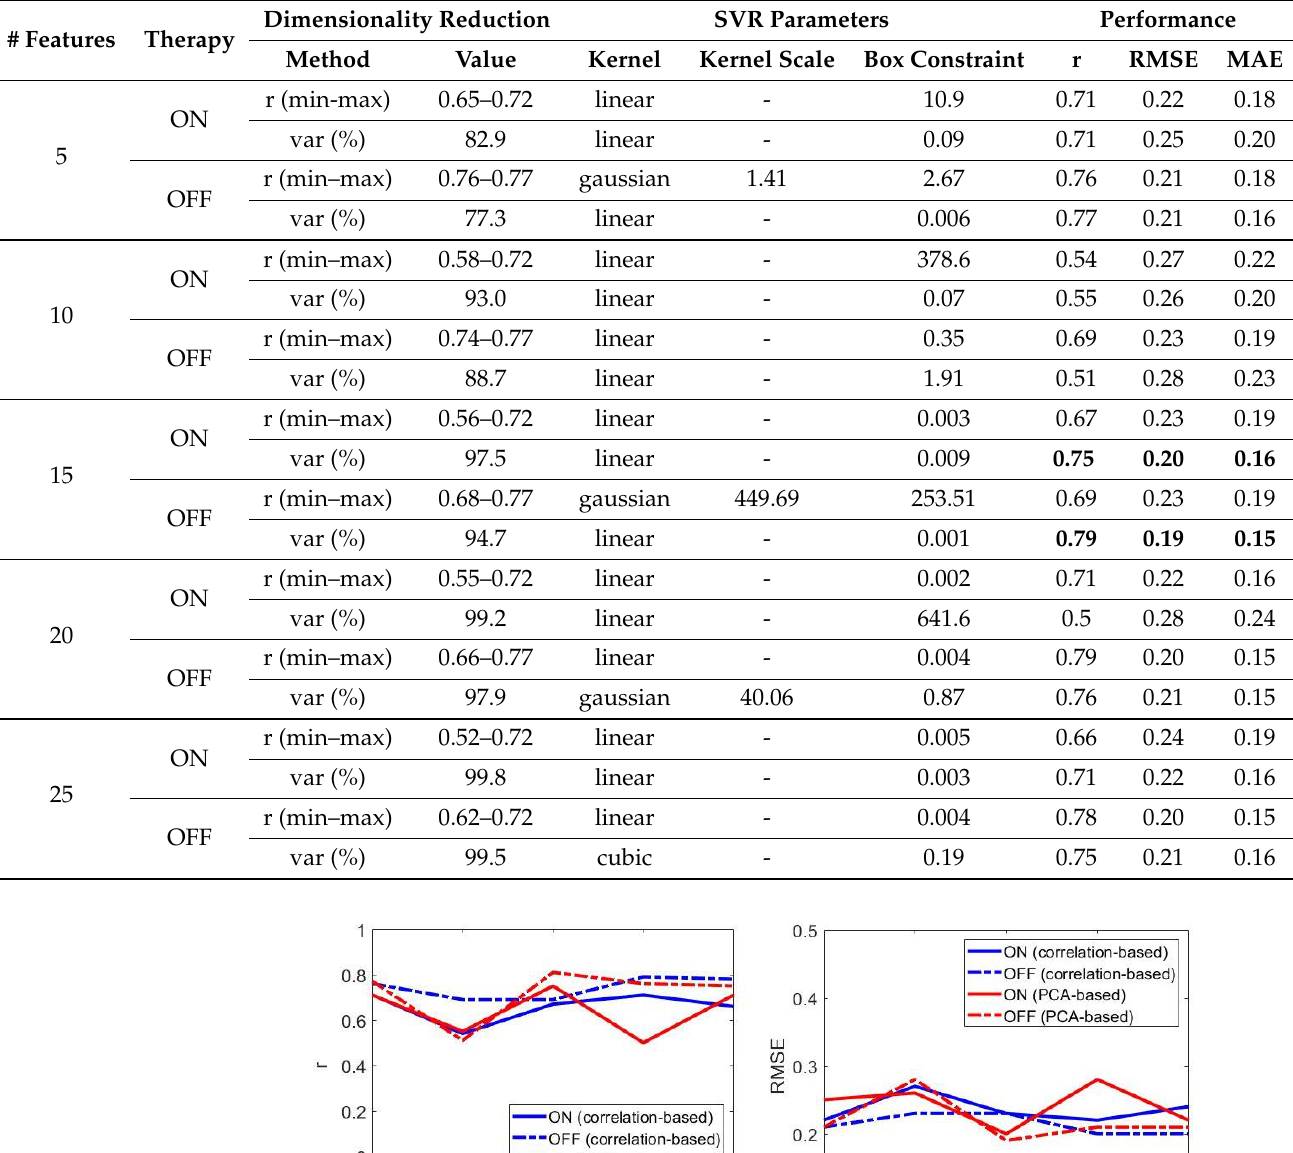
Table 7. Performance of regression models in different pharmacological conditions using leave- one-subject-out validation. Results were obtained for different sizes of the feature set and different dimensionality reduction methods. Best performances are marked with bold type. ON: under dopaminergic therapy; OFF: not under dopaminergic therapy; var: total variance explained; r: correlation coefficient; SVR: support vector regression; RMSE: root mean square error; MAE: mean absolute error.